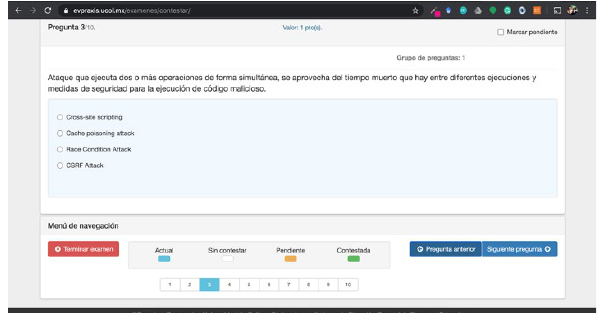
Figure 8. Online exam in